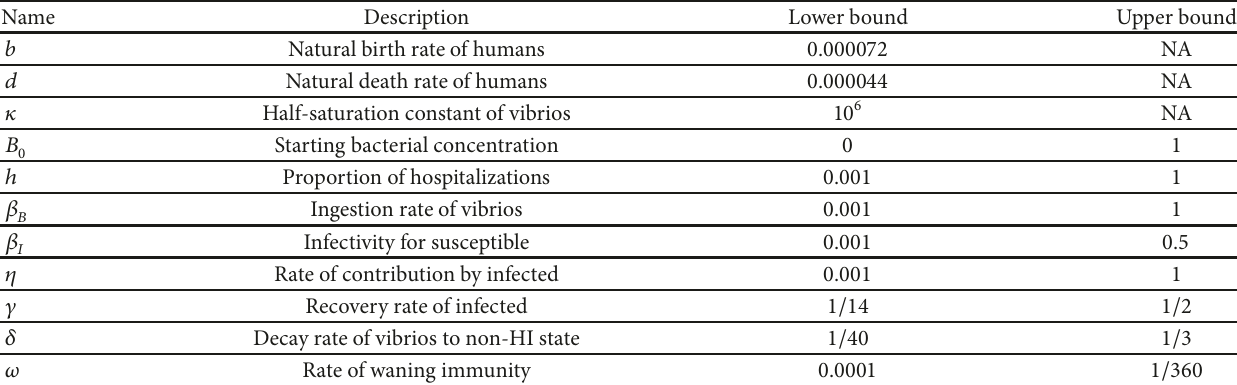
Table 2: Parameter ranges for cholera